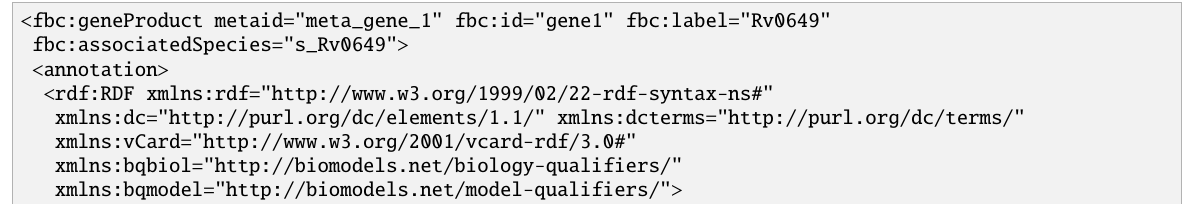
The id and name attributes